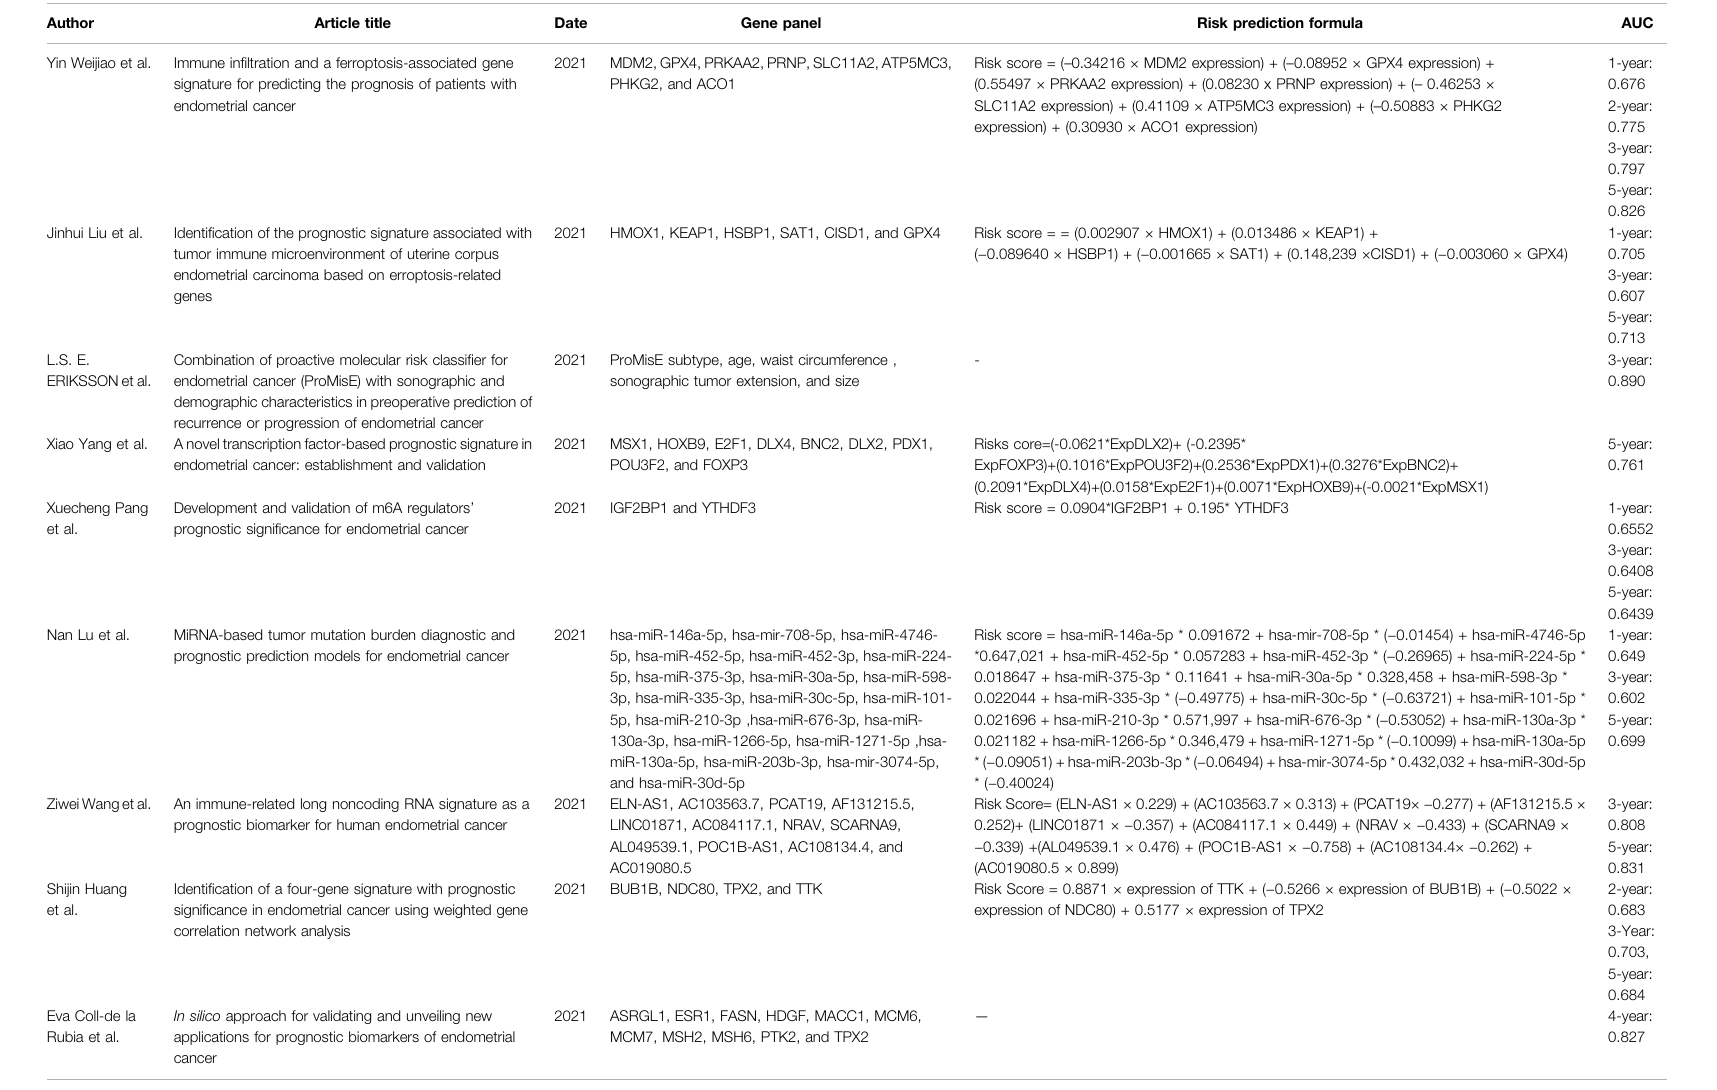
TABLE 1 | Molecular typing for endometrial